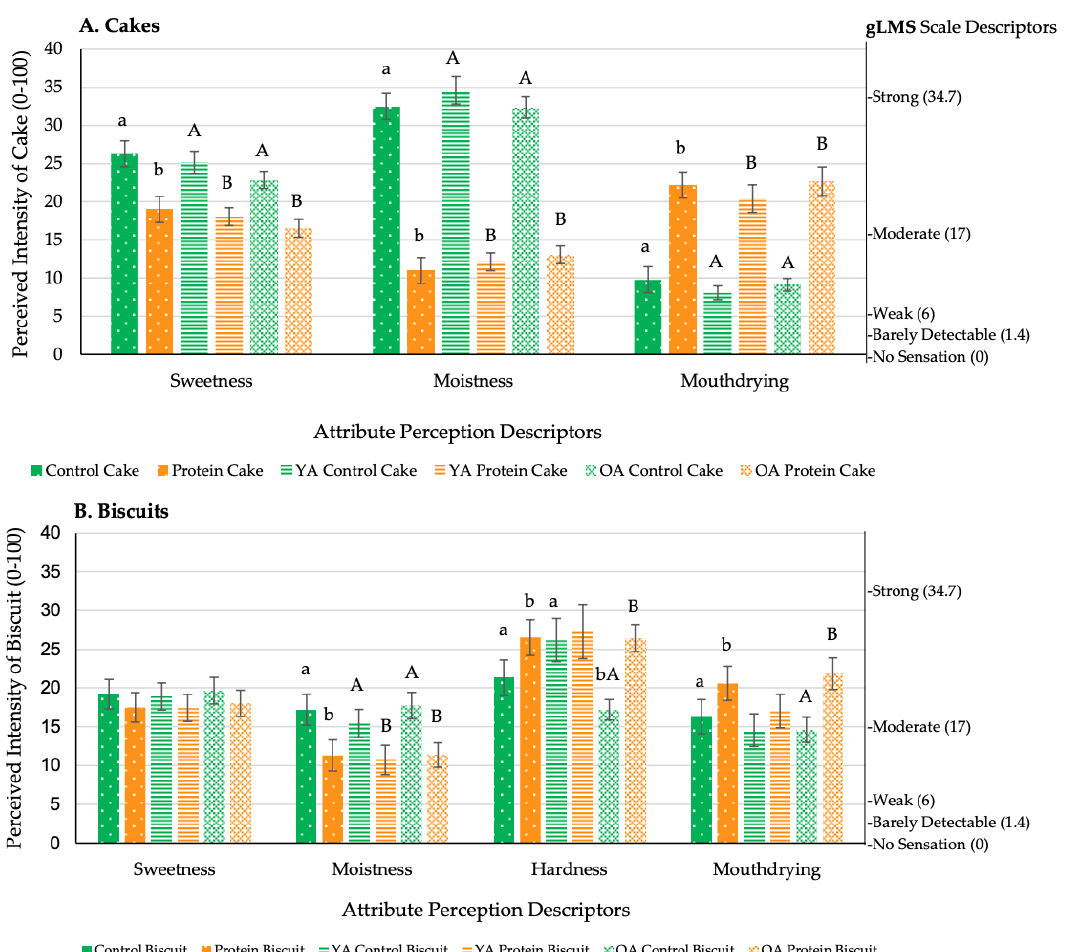
Figure 5. Volunteers attribute perception mean ratings of ( A ) cakes and ( B ) biscuits by overall and age (pilot study: n = 84; generalised Labelled Magnitude Scale (gLMS) anti-logged data, scale 0–100 summarised on the right of the figure). Values are expressed as LSM estimates ± standard error from SAS output. Significant differences ( p < 0.05) between samples (by overall: control vs. protein, and age: younger adults (YA) vs. older adults (OA)) are denoted by differing small letters, and significant differences within age groups are denoted by differing capital letters; no letter reflects no significant difference.